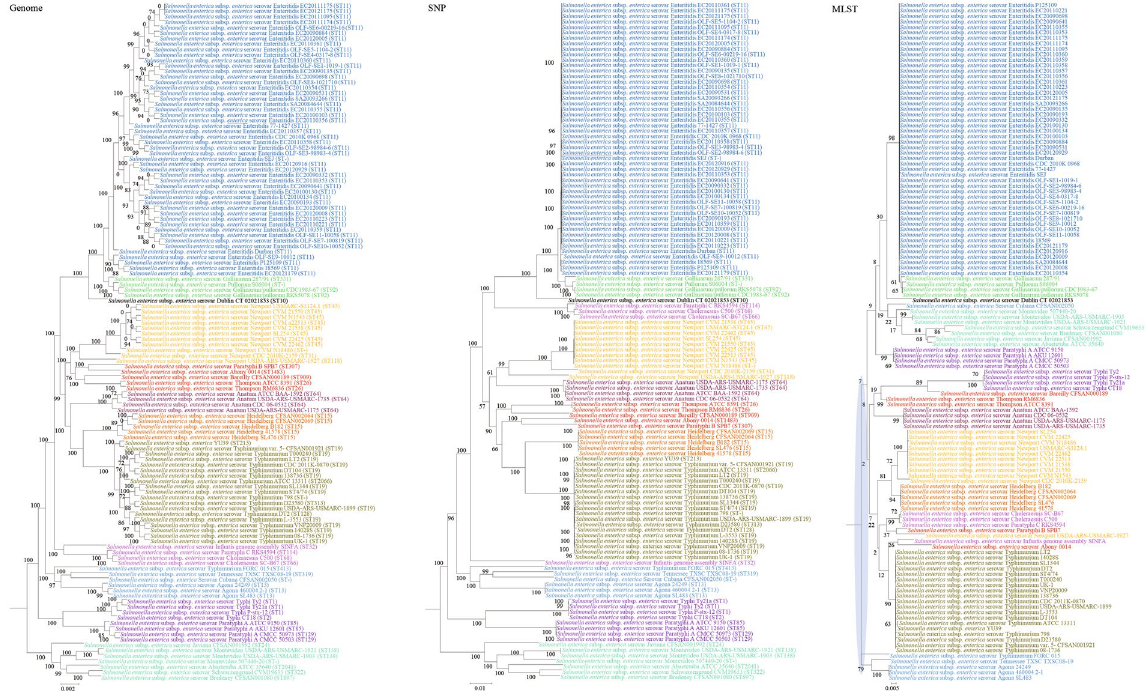
Figure 8. Comparison of phylogenetic trees constructed using genome data (left), SNP data (middle), and MLST data (right) for Salmonella enterica . Clusters that were manually selected based on the genome trees are illustrated in different colors. The unresolved polytomies are shaded in blue. A new sequence type is represented by a dash